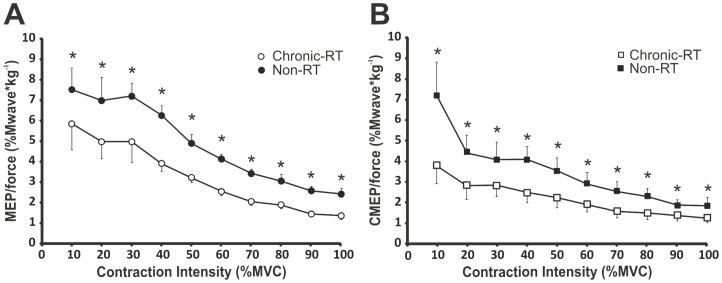
Between group differences in corticospinal responses (A) MEPs and (B) CMEPs of the biceps brachii normalized to absolute elbow flexion forces from 10–100% MVC.Each data point represents group means ± SE. * Indicates a significant (p≤0.015) difference between groups.